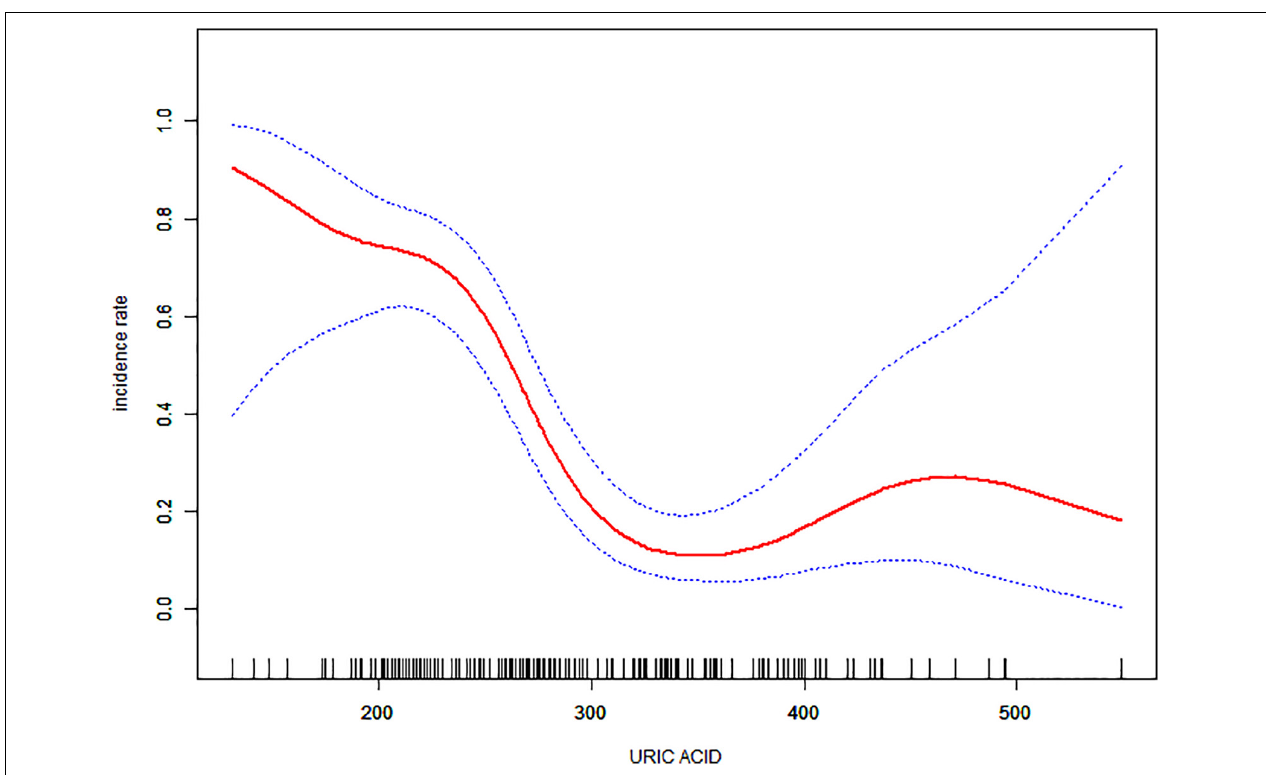
FIGURE 2 | The association of serum uric acid levels between the incidence rate of Meige’s syndrome. The adjusted data for the incidence rate of Meige’s syndrome is plotted against serum uric acid levels with a curve indicating the shaped relationship between the two. A threshold serum uric acid level of 337 µ mol/L existed for the regulation of uric acid.